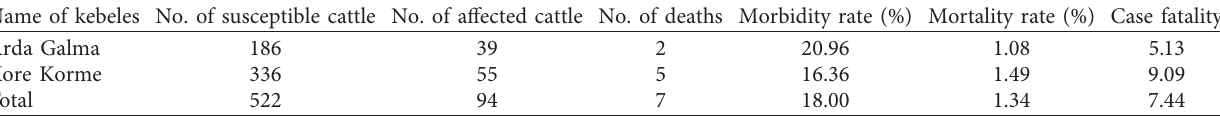
Figure 3: Characteristic signs of LSD with generalized circumscribed skin nodules covering the entire body. Encircled area shows developed circumscribed nodules on the skin. Pictures were taken during field Table 1: Morbidity rate, mortality rate, and case fatality rates of LSD outbreaks in the study area.